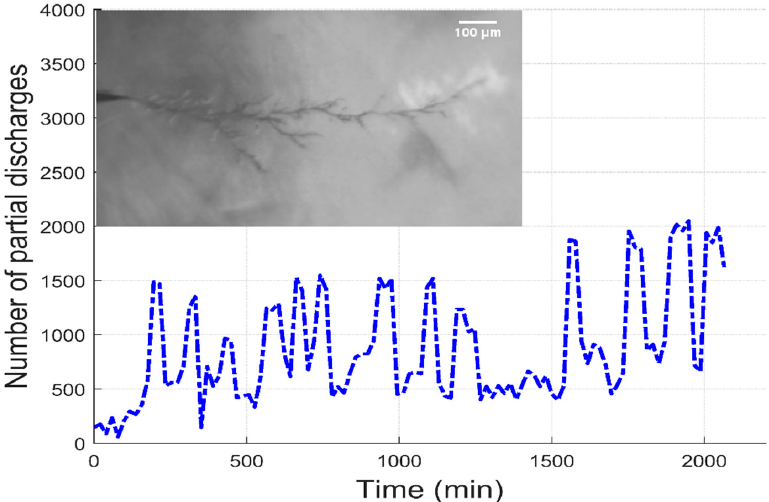
Figure 15. Partial discharge activities of ET growth under polarity reversal for case (IV) in Table 4.